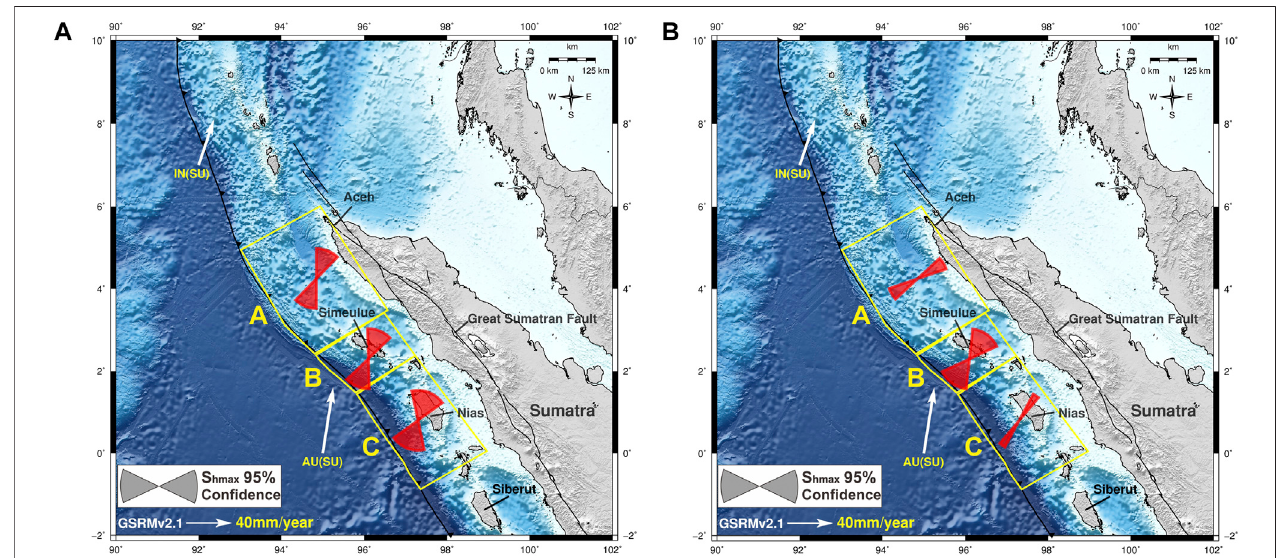
FIGURE 4 | Direction of maximum horizontal compressive stress (S Hmax ) for the pre-mainshock (A) and post-mainshock (B) stress fi elds in each of the segments A-C. 95% con fi dence intervals in the S Hmax directions are indicated by the width of each symbol. Red symbols denote pre- and post-mainshock S Hmax directions.